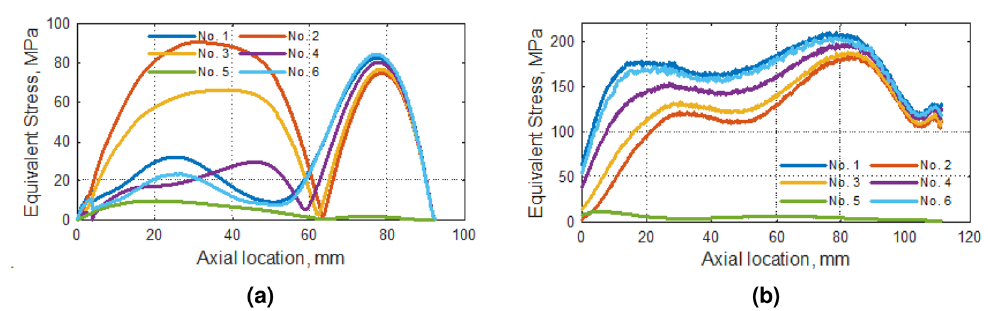
Figure 10. Equivalent stress distribution along ( a ) blade tip and ( b ) rounding between blade and compressor hub.